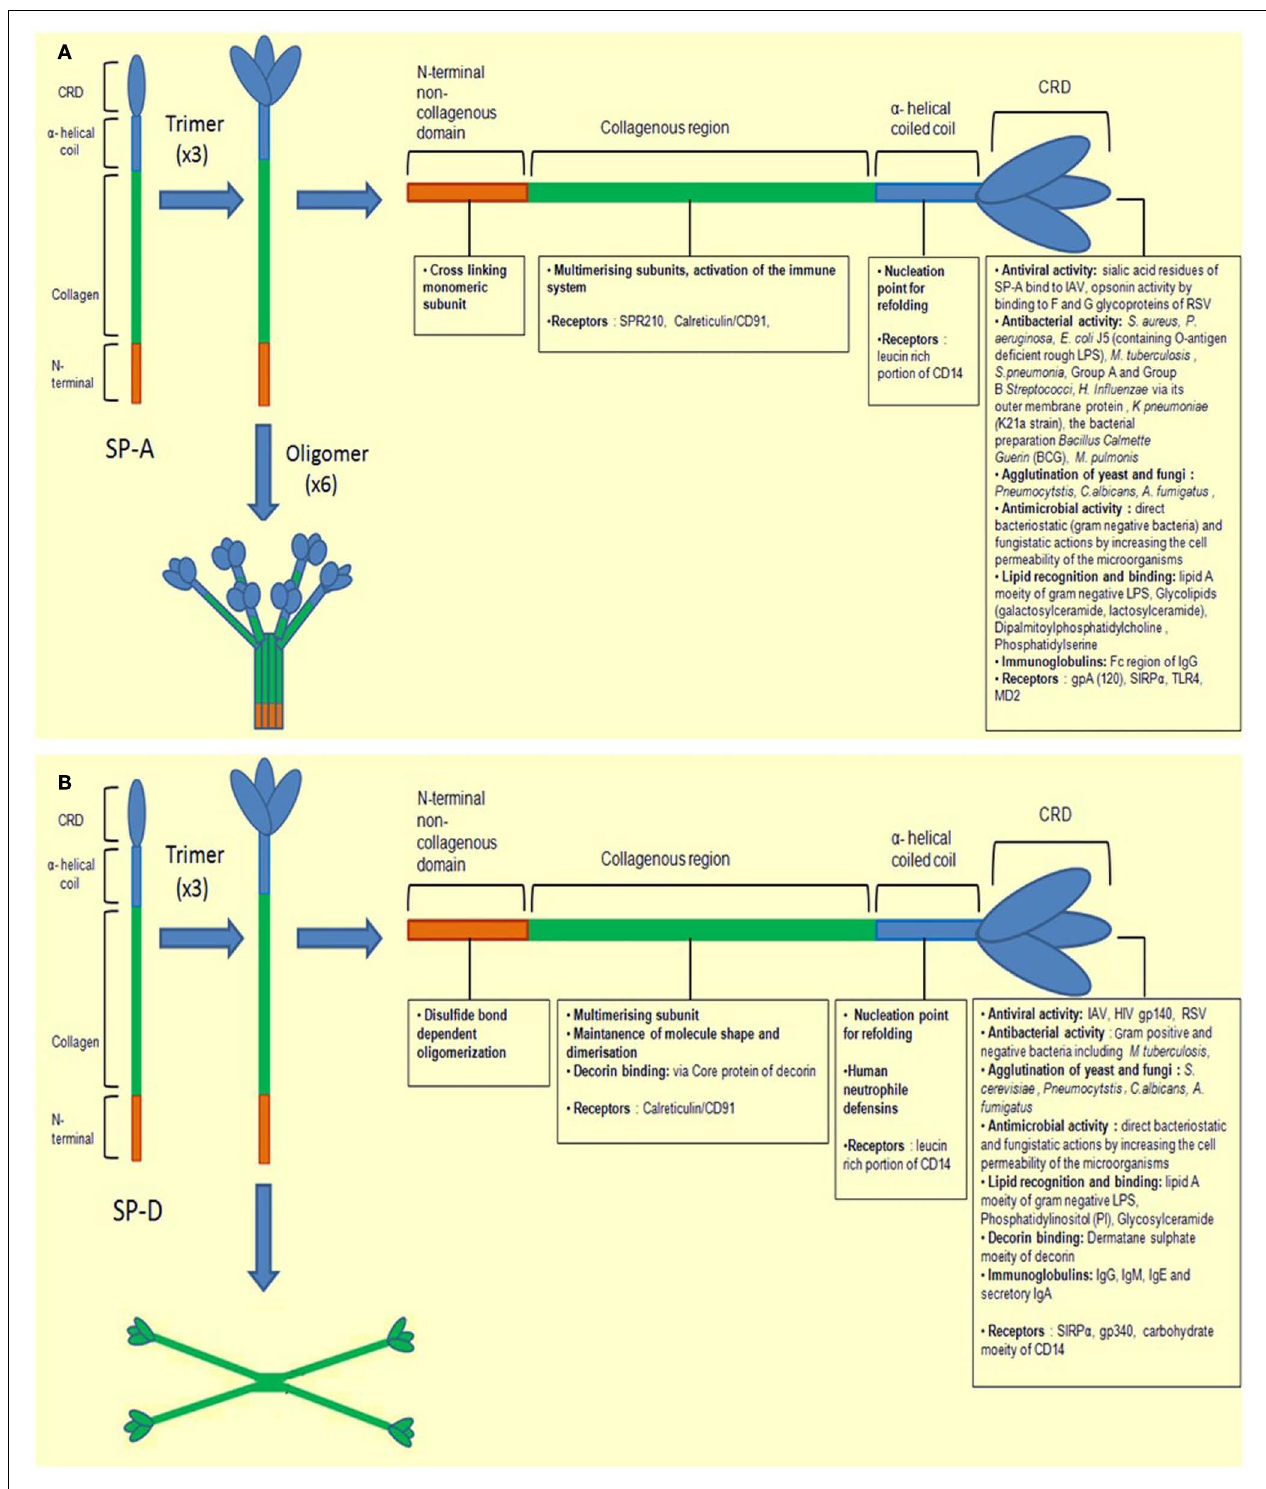
non-collagenous domain, collagenous region, helical neck, and C-terminal carbohydrate recognition domain. Each sub-unit has different ligand binding